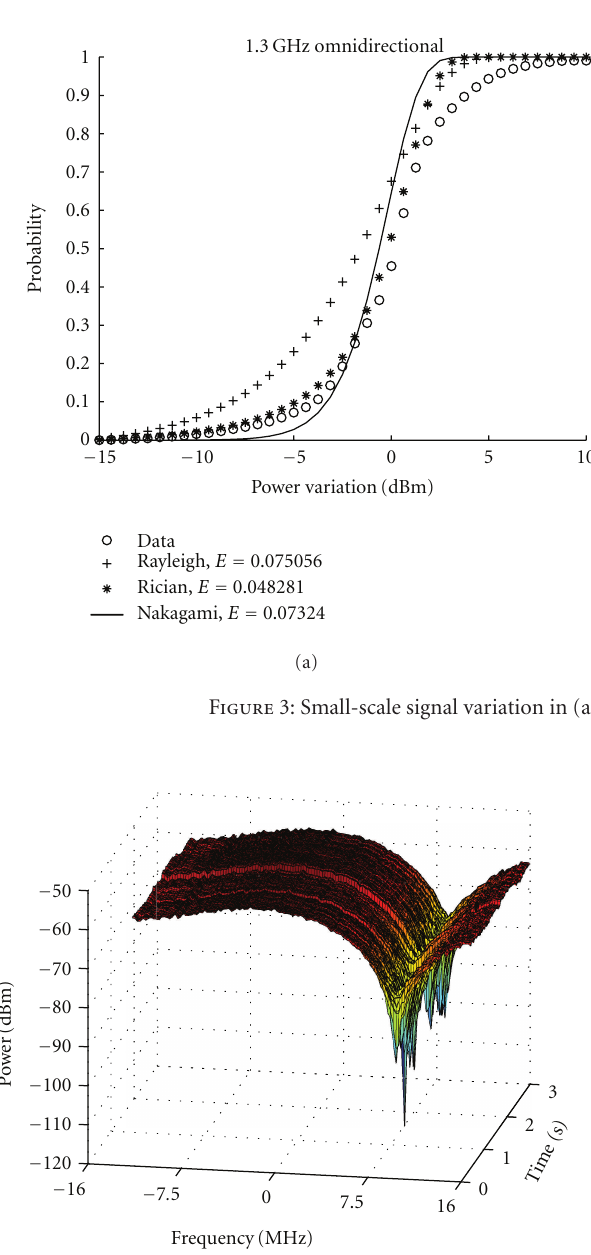
Figure 4: An example of frequency selective fading over time at 1.3GHz using directional antennas in a small room (3 . 6 × 3 × 7 .